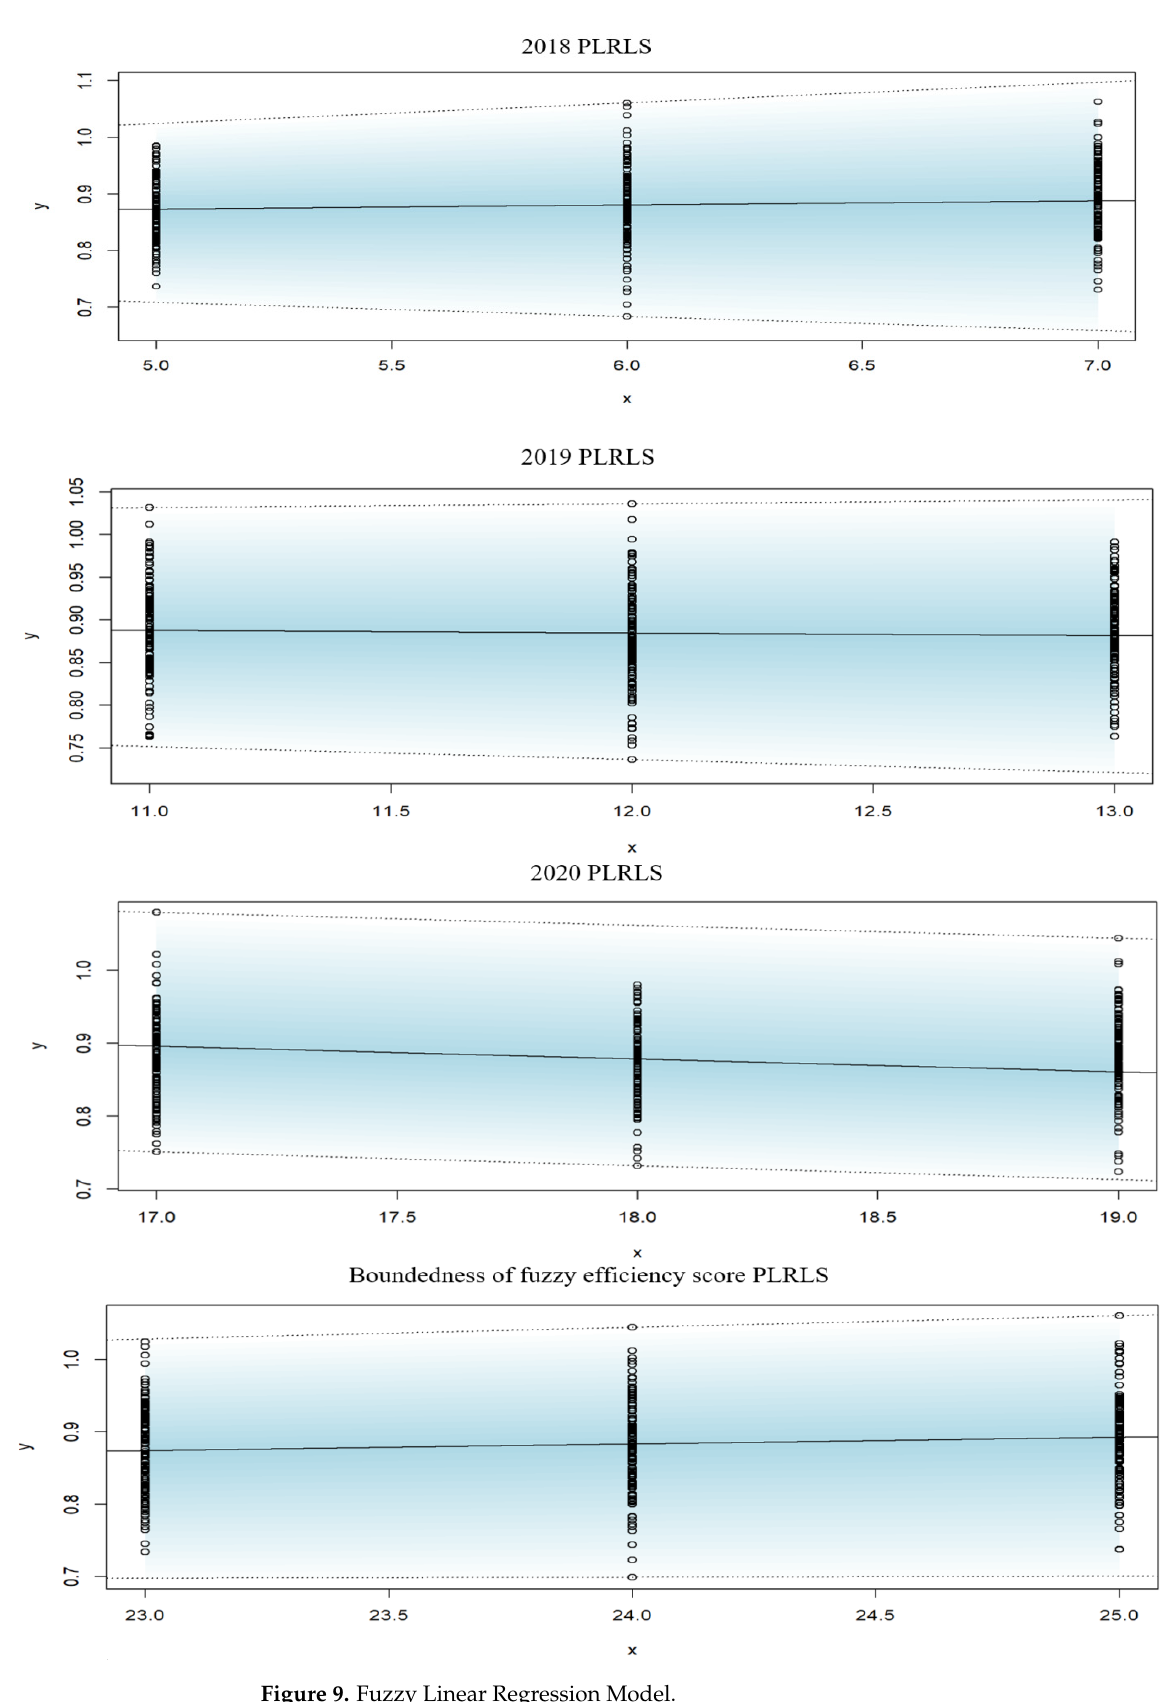
Figure 9. Fuzzy Linear Regression Model.